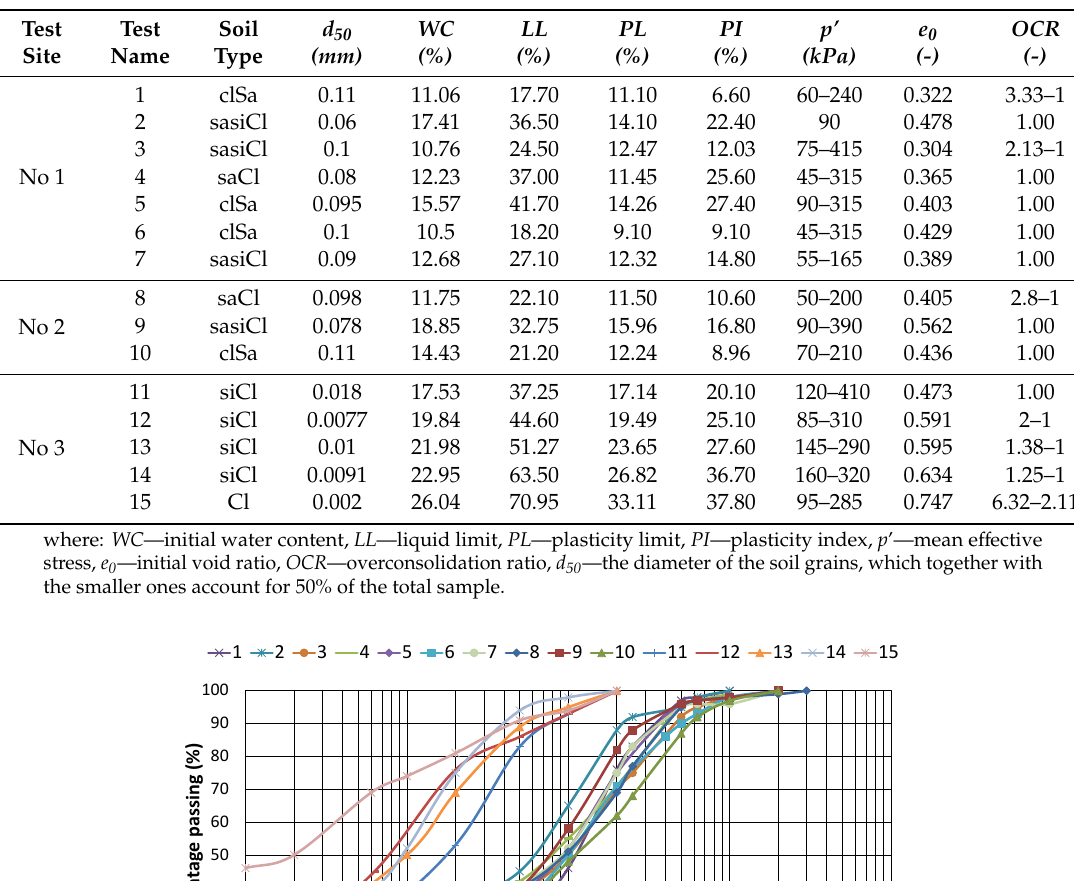
Table 3. Physical properties of test materials and the range of mean e ff ective stress.